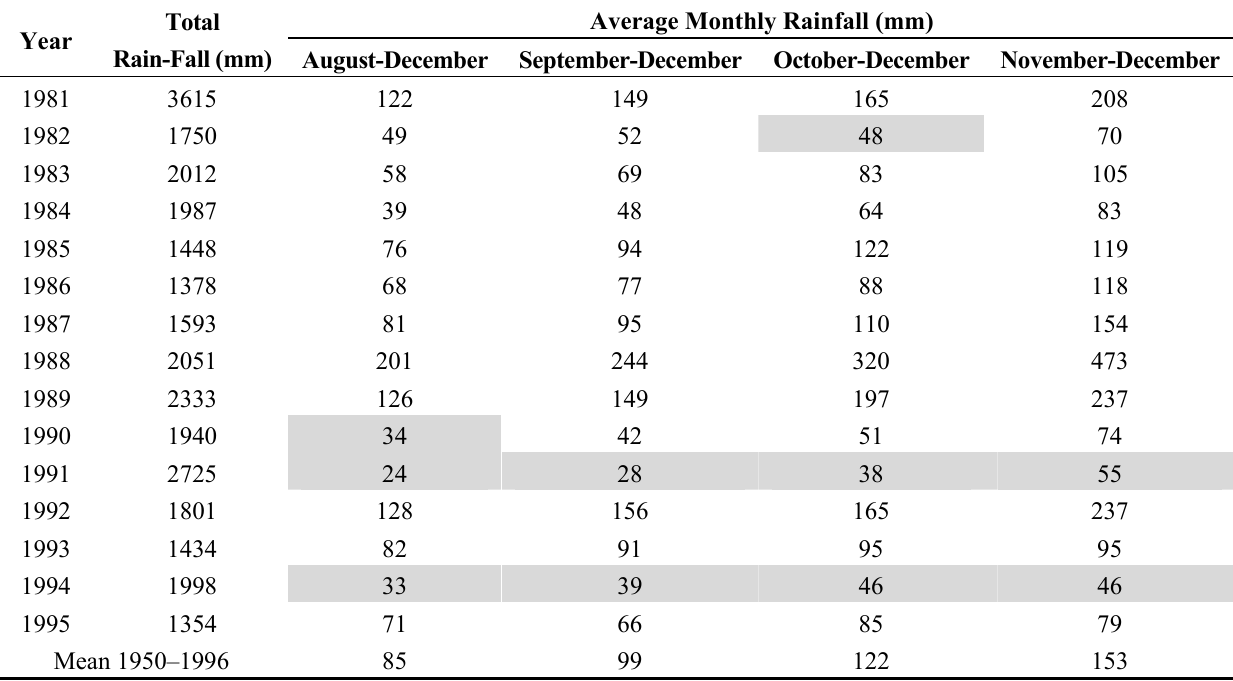
Table A1. Rainfall at Cardwell, 1981–1995: total for each year and mean monthly totals for last few months of each year. Shaded cells are those where rainfall is below the 20th percentile. (Bureau of Meteorology